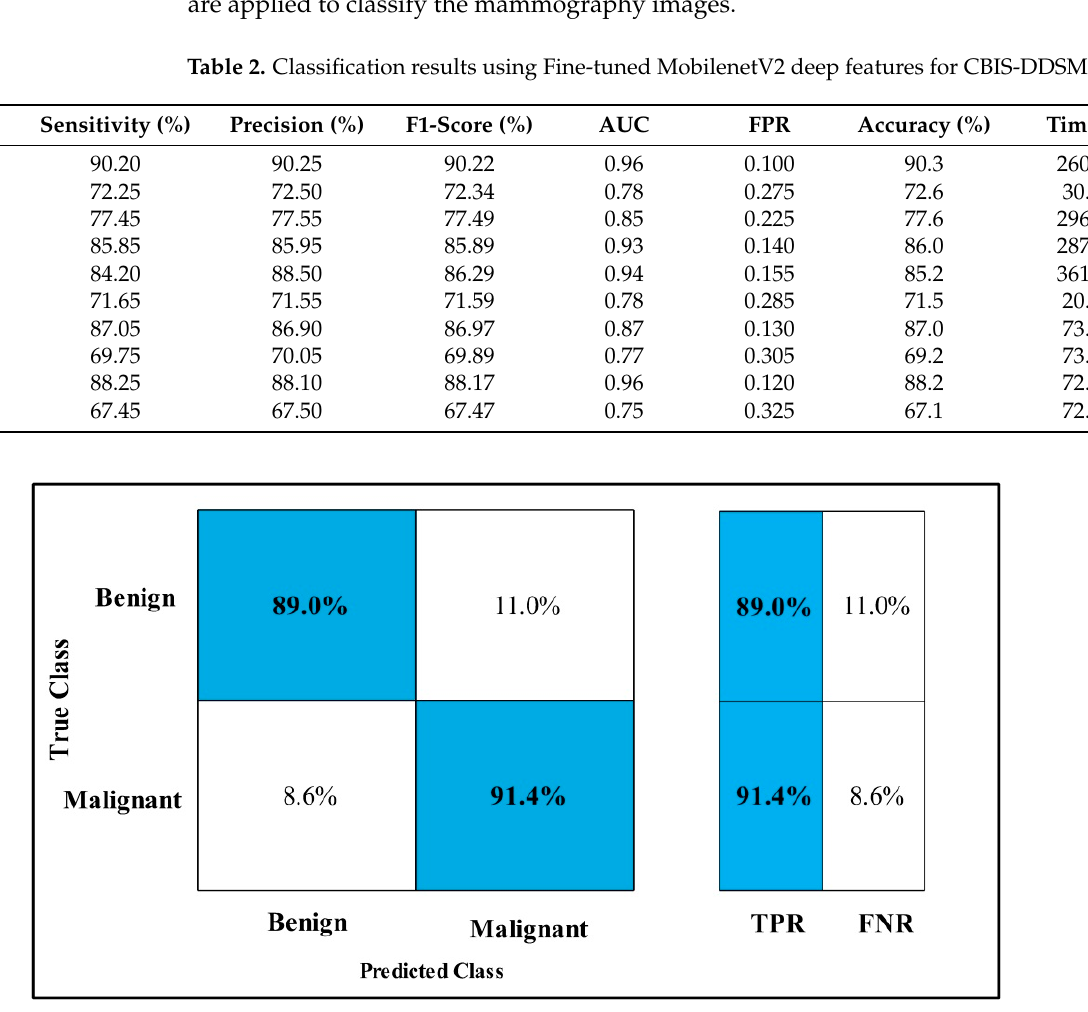
Figure 7. Fine-tuned MobilenetV2 TPR CBIS-DDSM. In Table 3, the Fine-tuned Nasnet model is applied to the CBIS-DDSM dataset. The deep features of the dataset are extracted from the GAP layer and fed to classifiers. The highest accuracy is 93.9%, which is achieved by the Cubic SVM classifier in 112.96 (s). In this table, the minimum time is taken by Fine Tree, which is 16.91 (s), but the accuracy is 89.8%, which is less than Cubic